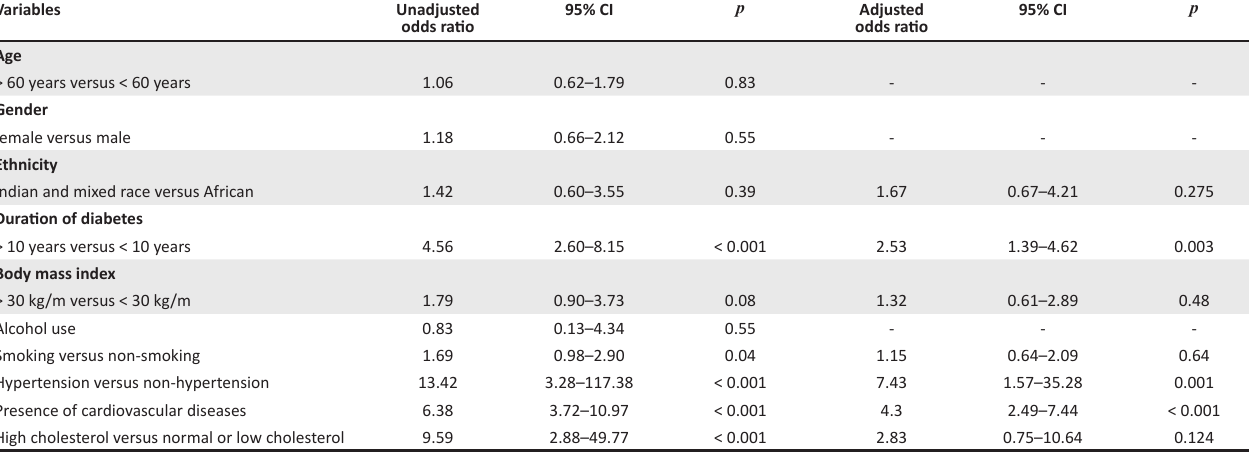
TABLE 3: Bivariate and multivariate analysis of patient’s socio-demographic and clinical factors associated with diabetic retinopathy. Variables